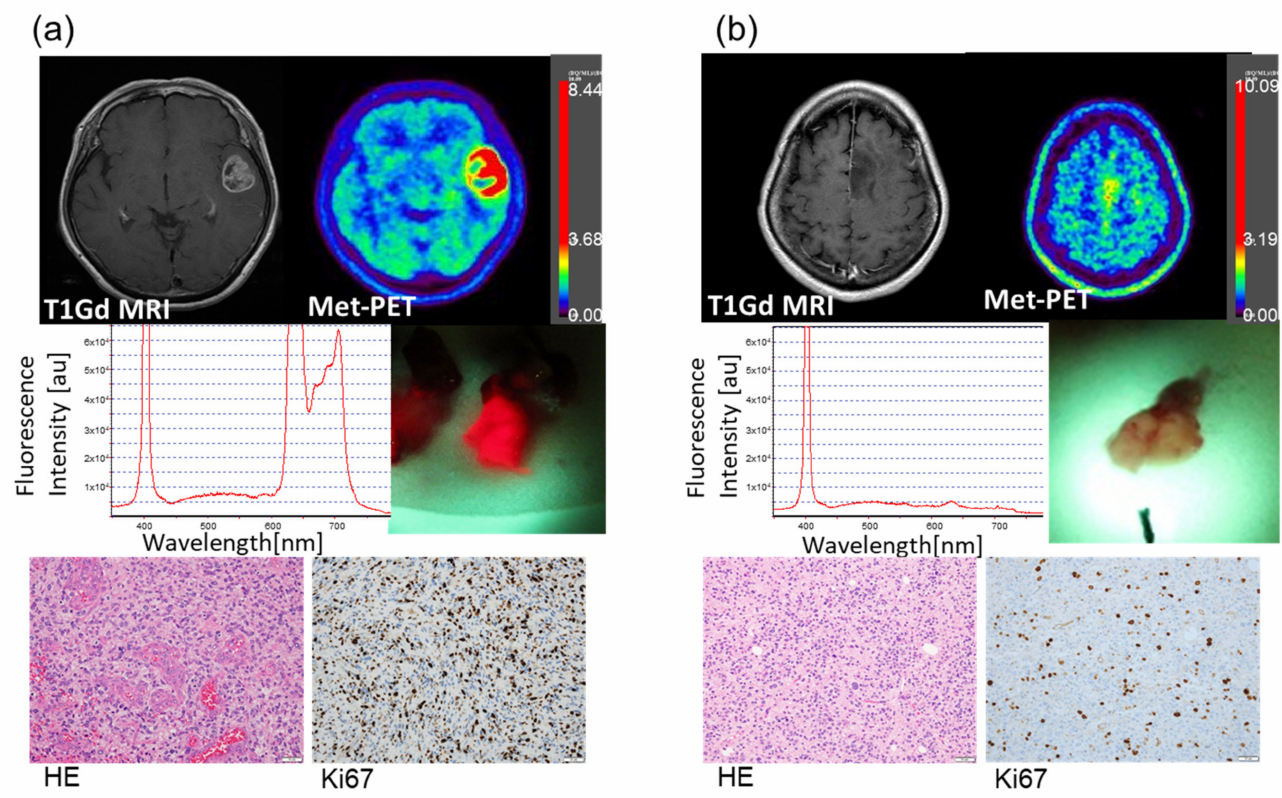
Figure 2. Illustrative cases. ( a ) A 67-year-old female with a newly diagnosed tumor in the left temporal lobe. Preoperative imaging showed ring enhancement on T1Gd MRI and high uptake on MET-PET. The SUV max (T/N ratio) of the MET-PET scan was 4.66. Bright red 5-ALA-induced fluorescence from the surgical specimen was captured and the intensity was detected by the quantification system. The peak at 635 nm was scaled out of the measurement range. There is a second peak of around 700 nm. This peak became apparent due to the high signals and was consistent with previous studies in which this second peak was noted [36]. Histopathological analysis revealed high cellularity with microvascular proliferation in hematoxylin and eosin-stained section. Immunohistochemistry with Ki-67 labeling showed abundant proliferating tumor cells with 43.4% positivity. The final diagnosis was Glioblastoma, IDH wild type. ( b ) A 44-year-old female with a newly diagnosed tumor in the left frontal lobe. In the preoperative imaging, the tumor showed no enhancement on MRI, while the SUV max (T/N ratio) of the MET-PET scan was only mildly elevated (2.57). Repeated scanning of the tumor specimens failed to detect 5-ALA-induced fluorescence. Histopathology revealed densely proliferating tumor cells with Ki-67 index of 14.0%, without evidence of microvascular proliferation or necrosis. The final diagnosis was Anaplastic astrocytoma, IDH